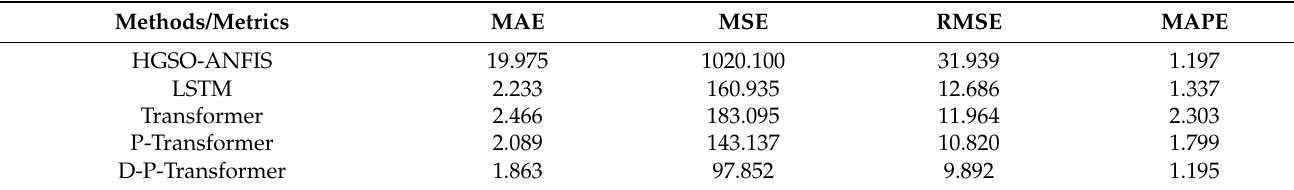
Table 4. The performance comparison of various